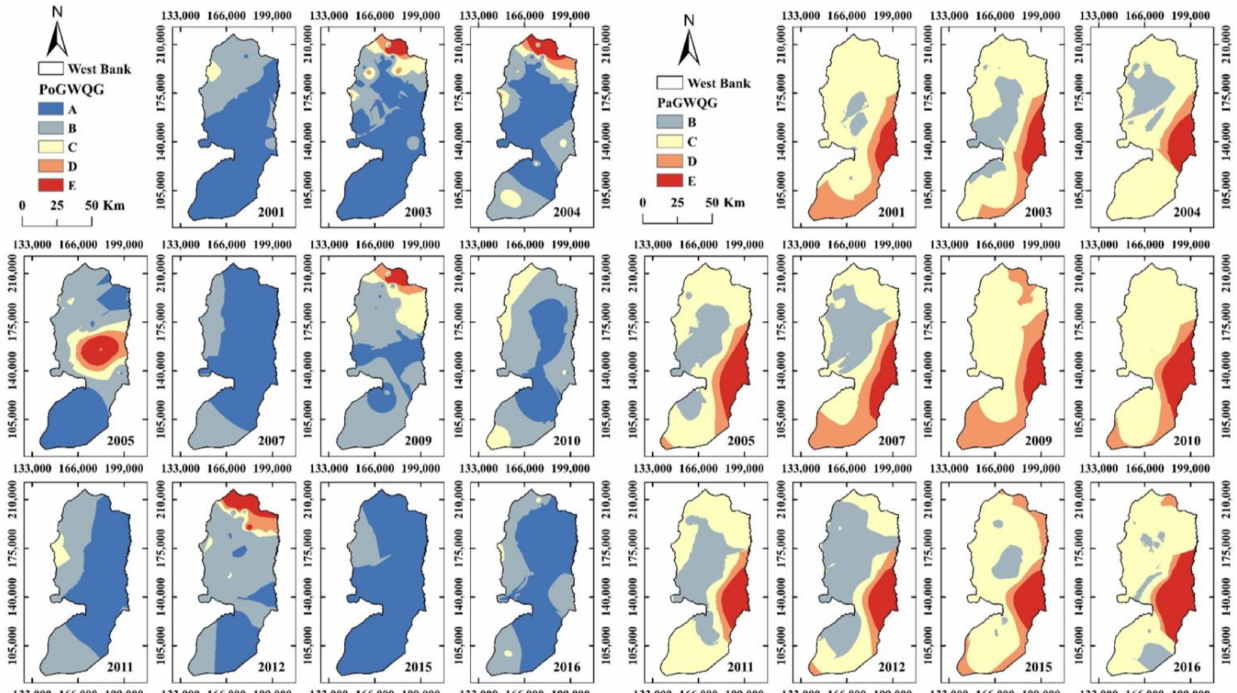
Figure 6. Spatiotemporal mapping of PoGWQI and PaGWQI in the West Bank between 2001 and 2016.